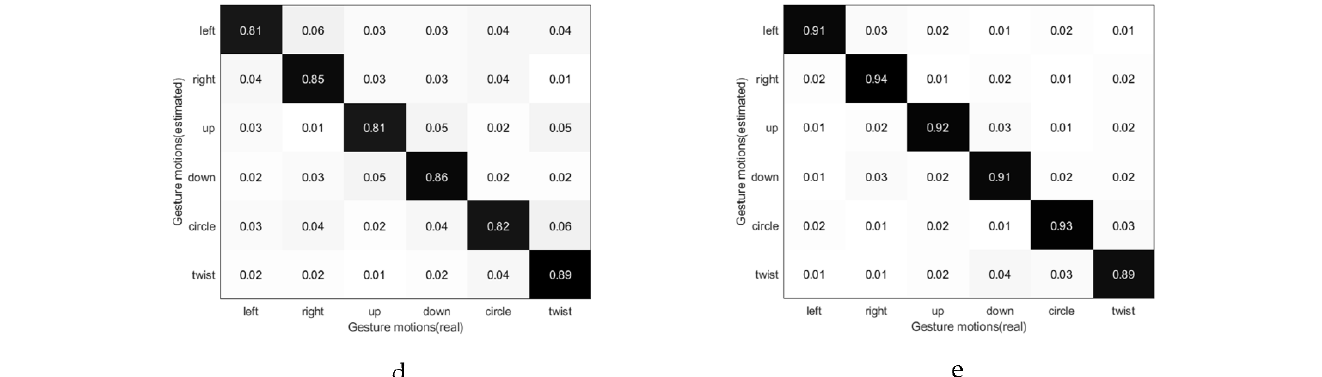
Figure 22. Confusion matrix. ( a ) The confusion matrix of the recognition results of the known scene domain, ( b ) The confusion matrix of unknown scene domain identification results, ( c ) The confusion matrix of the experimental location scene domain, ( d ) The confusion matrix of the experimental direction scene domain, ( e ) The confusion matrix of any scene domain in the experiment.